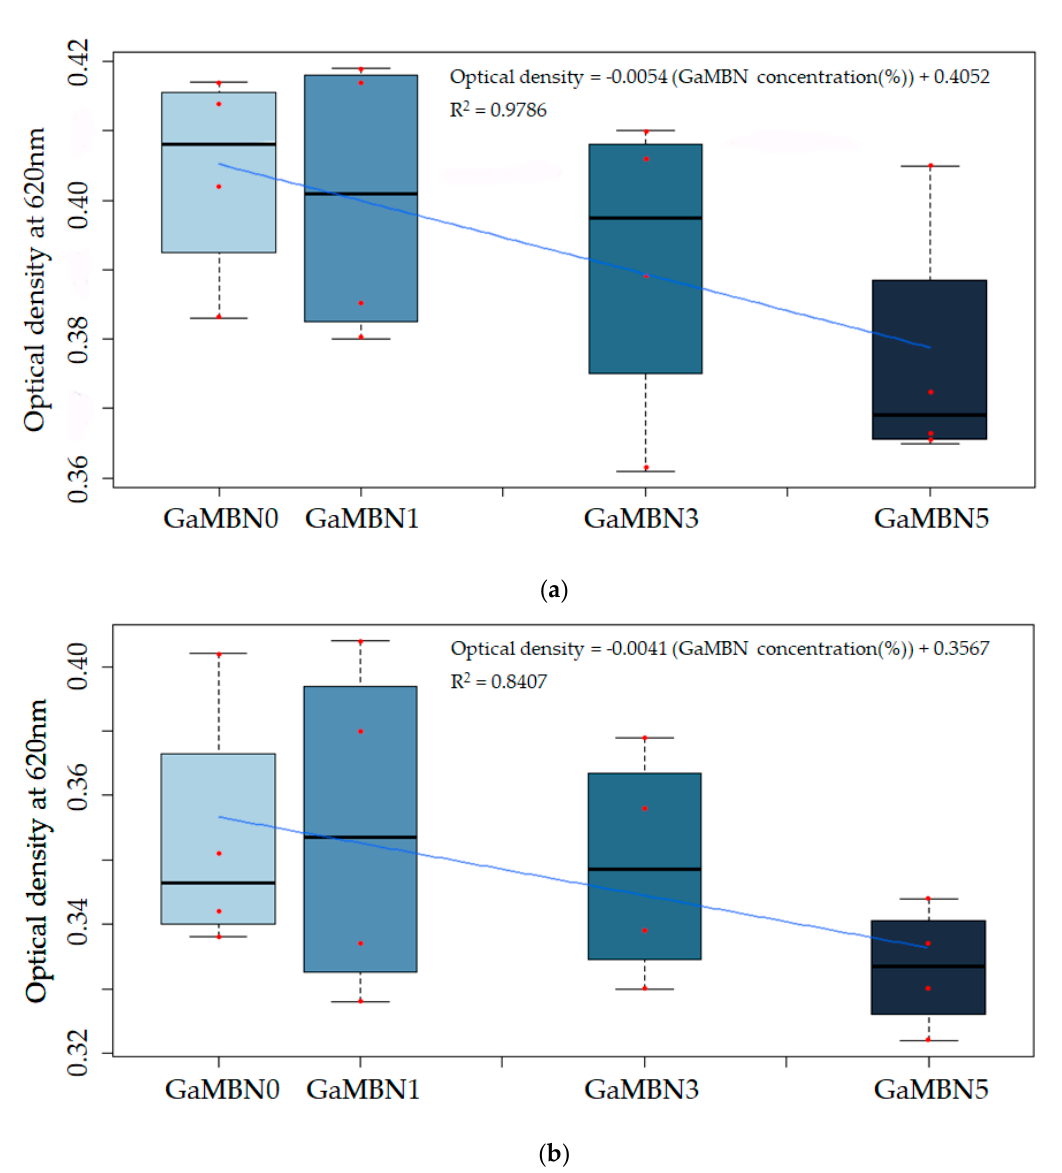
Figure 11. The antibacterial properties of the cured GaMBN-containing orthodontic bonding pastes after ( a ) 24 and ( b ) 48 h were not statistically significantly different from that of GaMBN0 ( p < 0.05) based on Duncan’s multiple comparison test. Error bars represent the standard error (n = x ). Correlation between optical density and the GaMBN concentration of the resin disk.